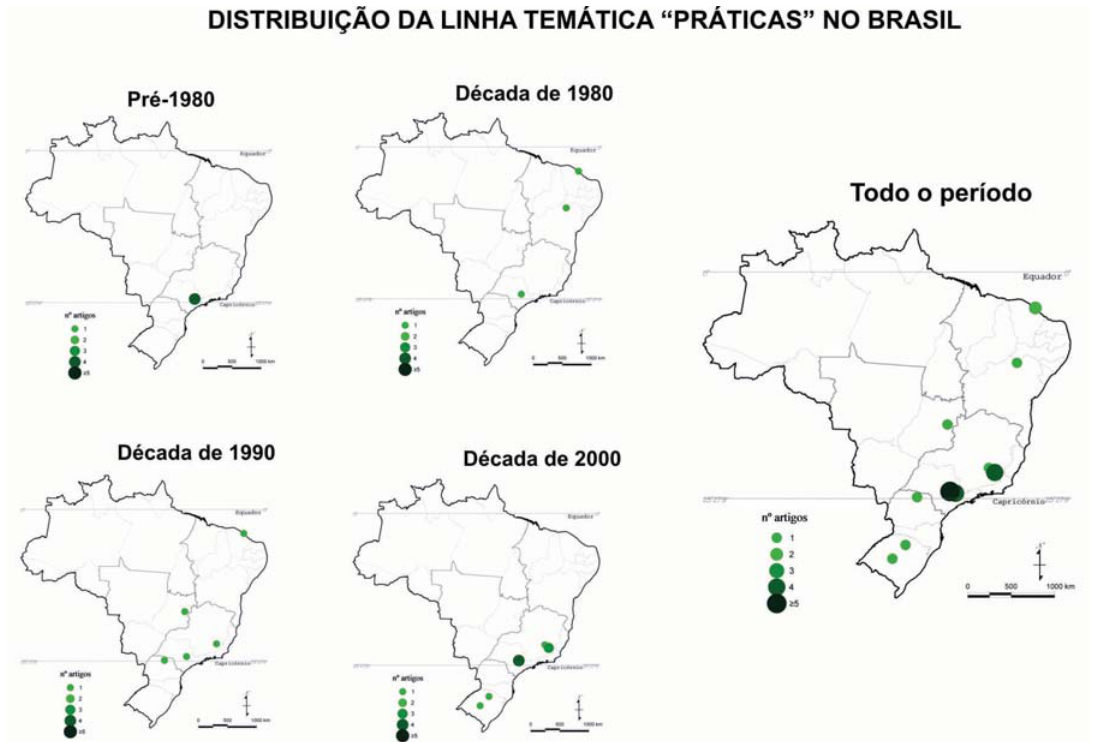
Figura 6. Distribuição espacial da produção de artigos na linha temática “PRÁTICAS” por